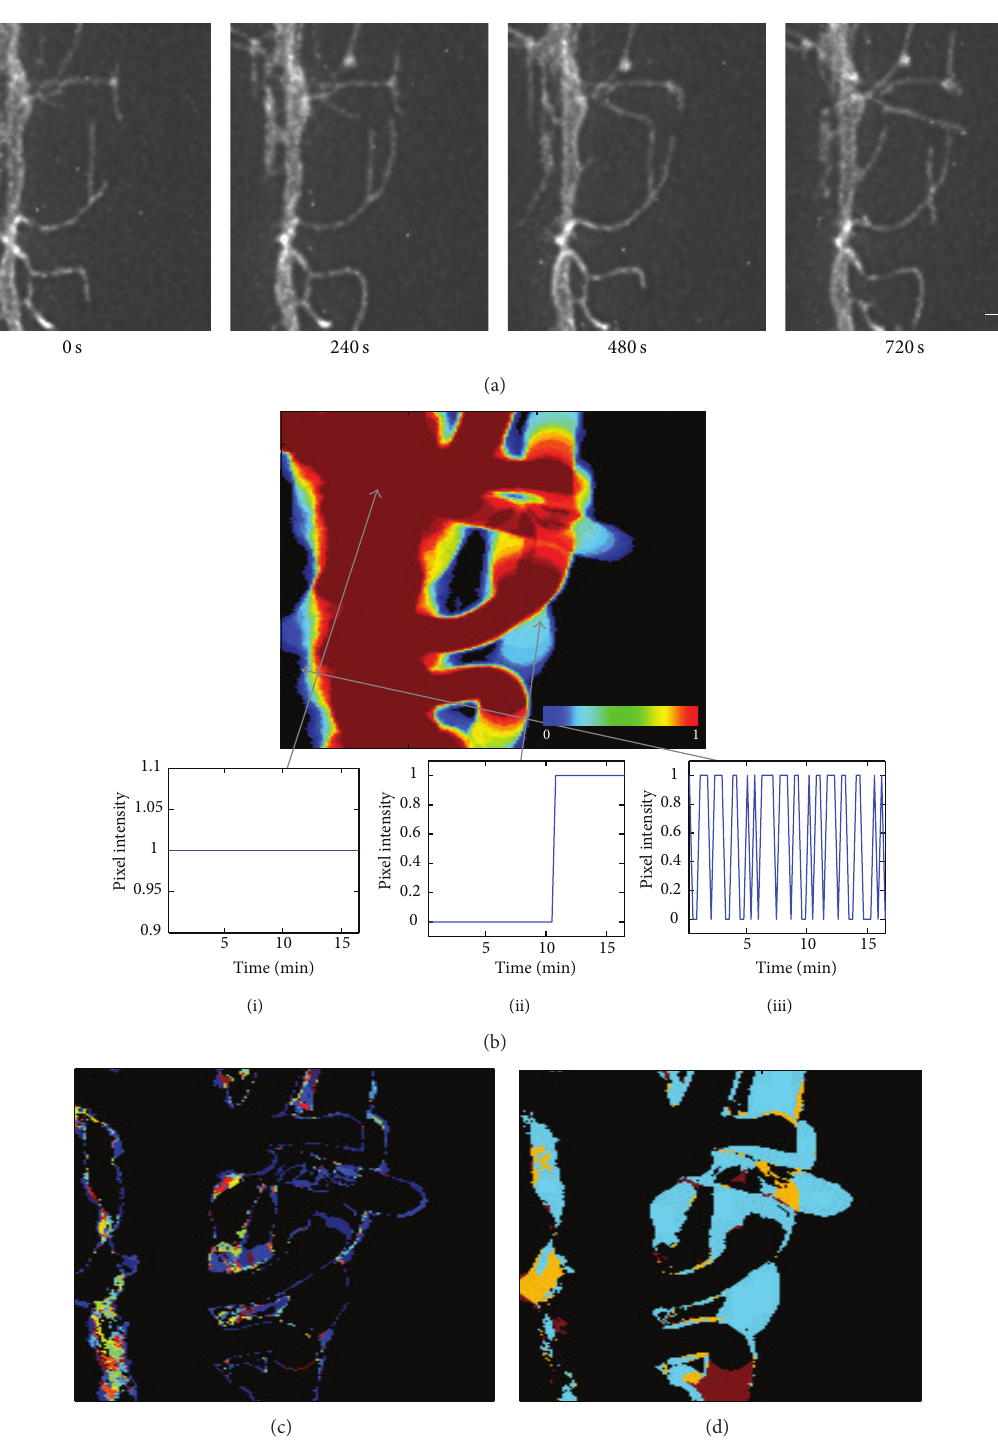
Figure 4: Temporal frequency filtering helps exclude artifactual pixel redistributions. (a) Time series of two-photon images of a portion of a radial glia cell. Scale bar = 2 𝜇 m. (b) Integrated intensity of a healthy cell over the course of 18 minutes, preprocessed for analysis. Red pixels have a value of 1 during most time points and blue pixels during few time points. Black pixels are negative background sites with value 0 at all time points. Time-dependent pixel intensity functions (i) for a pixel located within the main process, (ii) for a pixel into which a filopodium extended, and (iii) for a noisy pixel located along the edge of the cell. (c) Frequency map showing noisy pixels that were discarded by temporal frequency filtering. The colors represent discrete high frequencies measured in the excluded range. (d) Frequency map of the same cell, showing pixels that were accepted by the frequency filter. Each color shows a discrete frequency within the accepted range. In (c) and (d), black represents sites where pixel intensity did not change over the 18